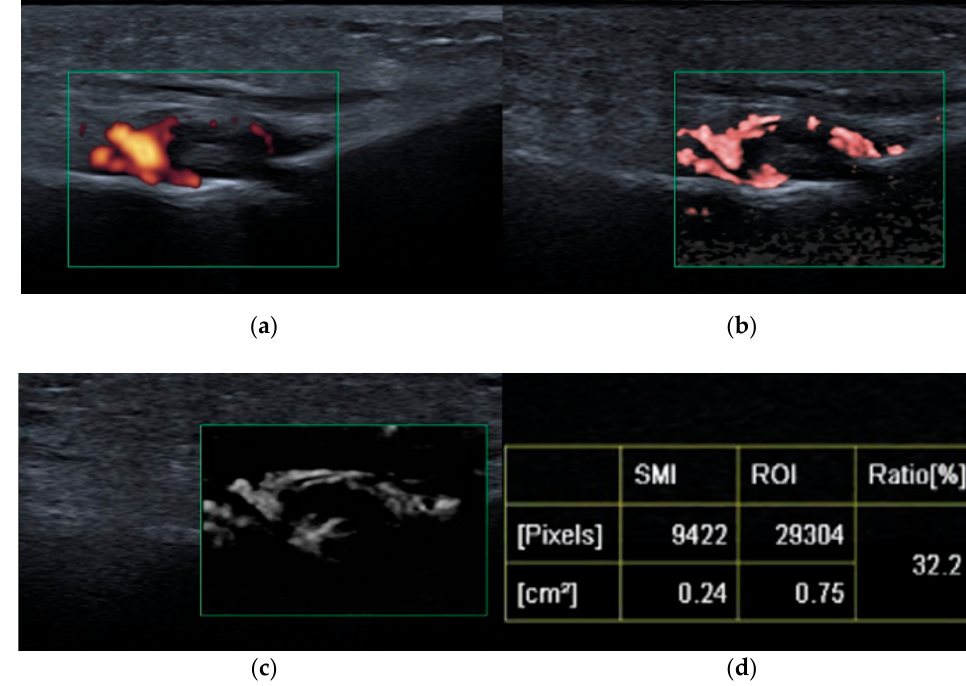
Figure 1. Third metatarso-phalangeal (MTP3, green square) joint synovitis shown on: power Doppler ultrasound (PDUS) ( a ), color superb microvascular imaging (SMI) ( b ), monochromatic SMI ( c ), and vascularity index ( d ); improved detection of hyperemia (vessels) achieved with SMI compared with PDUS.